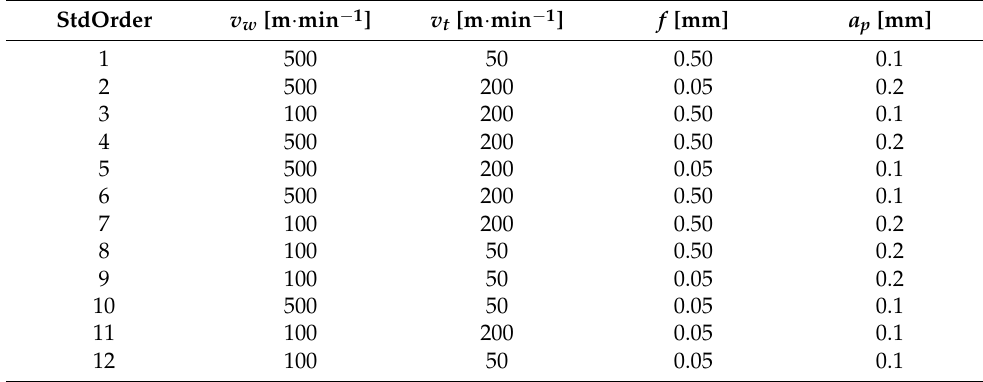
Table 2. Process parameters and their values in the